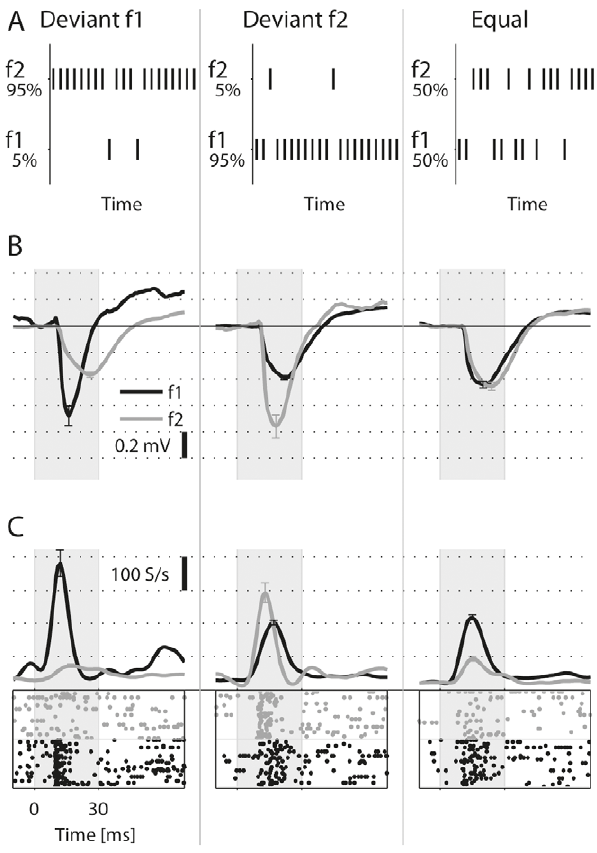
Figure 1. The oddball paradigm. A. A schematic spectrographic representation of the three basic sequences used in this study. In each trial, either f1 or f2 are presented pseudo-randomly according to their probability of occurrence. B. The average LFP responses in a typical recording site to the two frequencies of the paradigm in each of the sequences (f1=13.3 kHz, black, and f2=19.2 kHz, gray). The level was 30 dB attenuation ( , 70dB SPL). Error bars: 6 s.e.m., shaded interval: stimulus. C. MUA Responses at the same site. The raster plots show 25 presentations for each of the two frequencies, corresponding to 5% of the 500 tone presentations in the sequence. For the standard and equal-probability conditions, which had more than 25 presentations in a sequence, the 25 presentations were selected so that they represent the spike count distribution of all responses in the time window shown. The line graphs represent PSTHs smoothed by a 10 ms Hamming window.